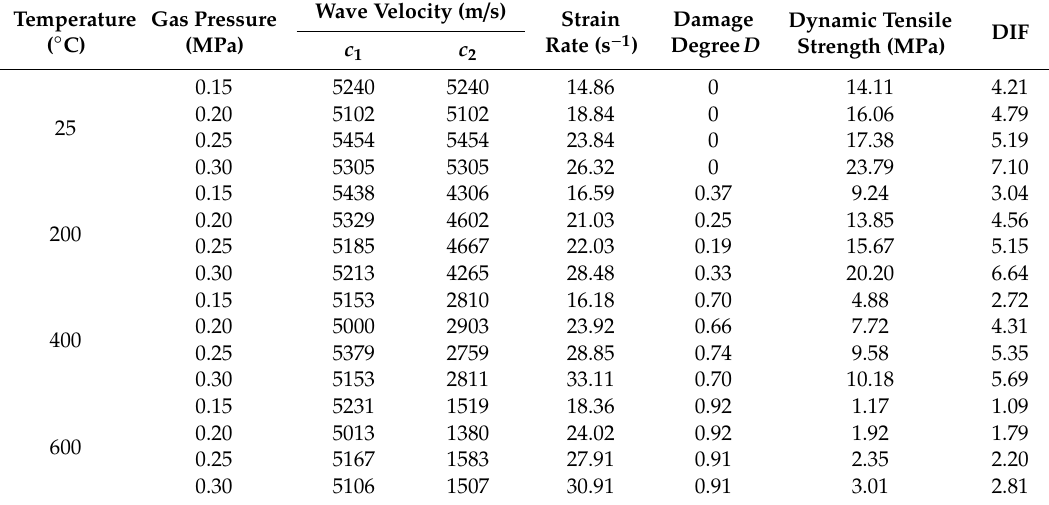
Table 3. The mechanical properties of concrete under dynamic splitting tensile tests.